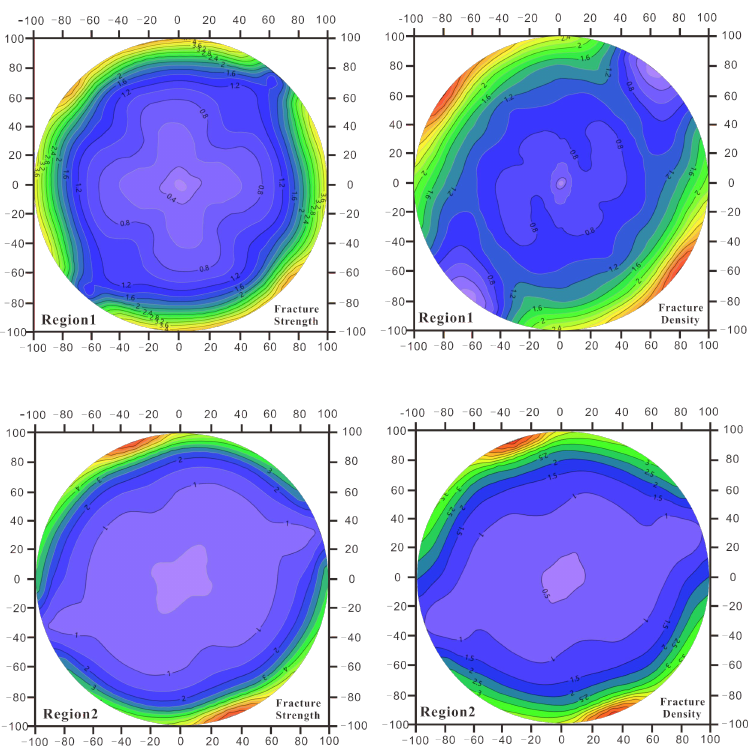
Figure 18. Measured data study area 1 and study area 2; fracture strength and fracture density half variance contour map.